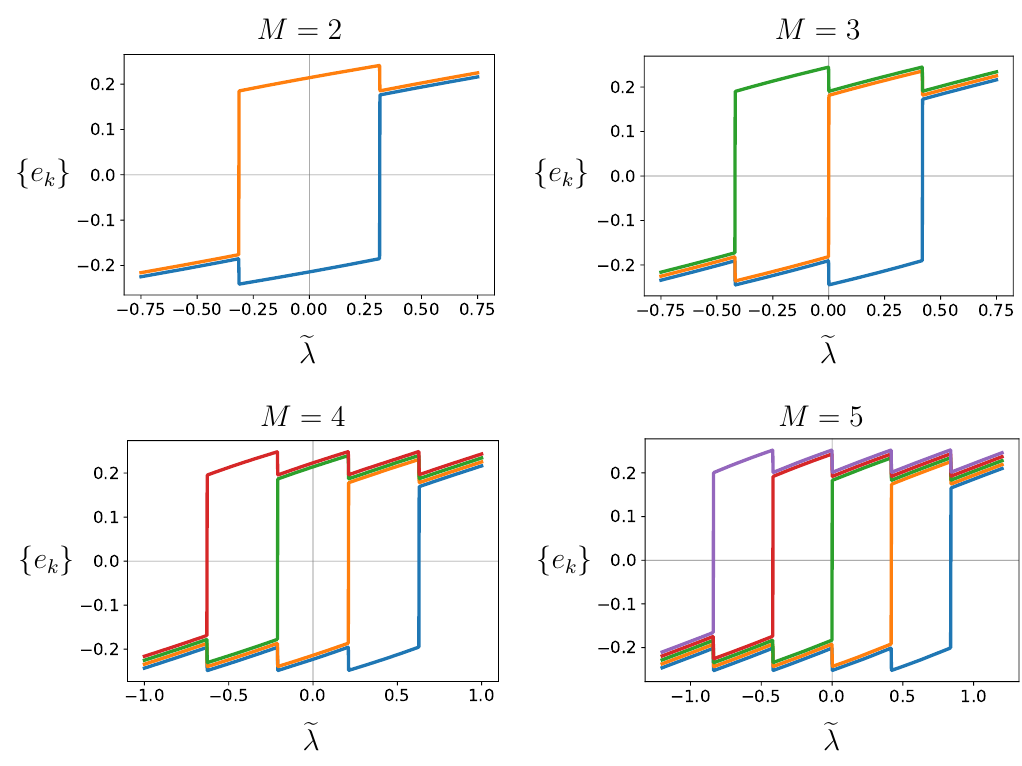
g 1 = 1 and g 2 = 3 at T = µ = 0 . Each e e